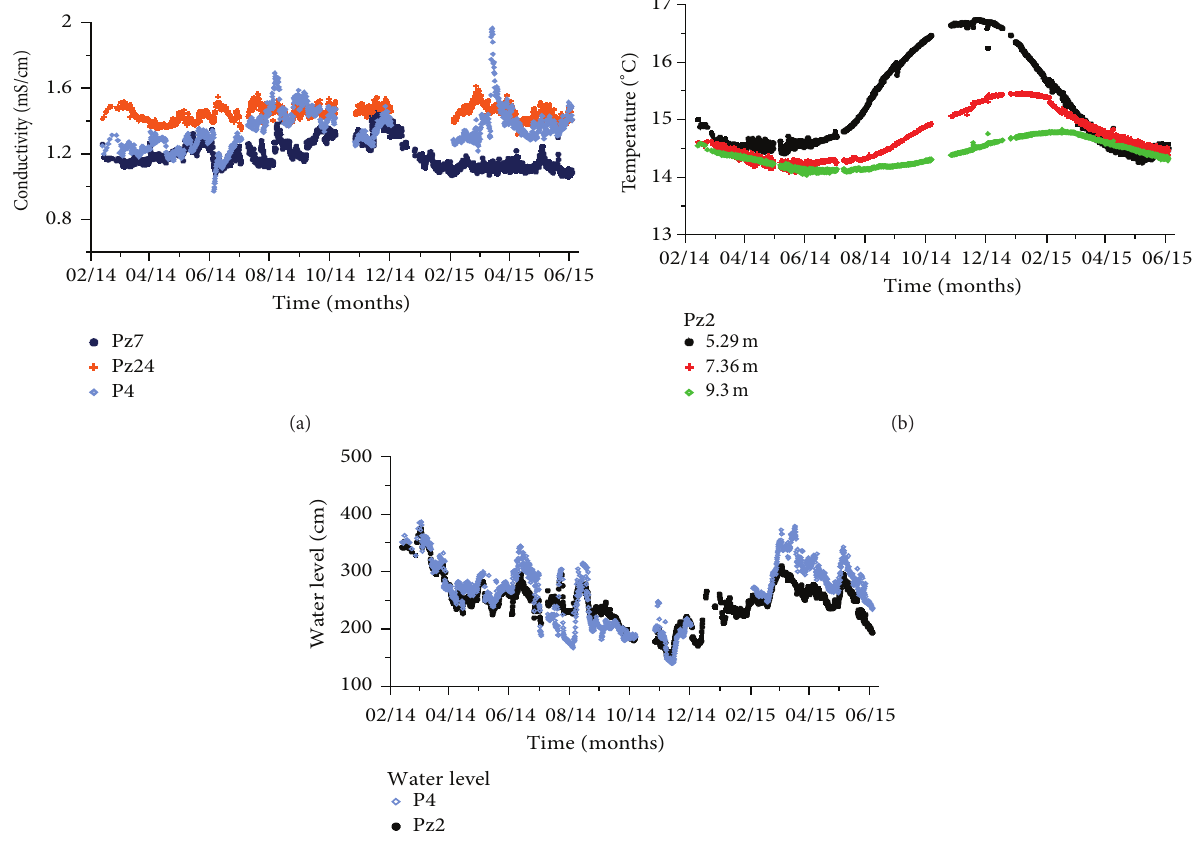
Figure 9: Water conductivity (a) and temperature (b) and ground water level (c) evolution over